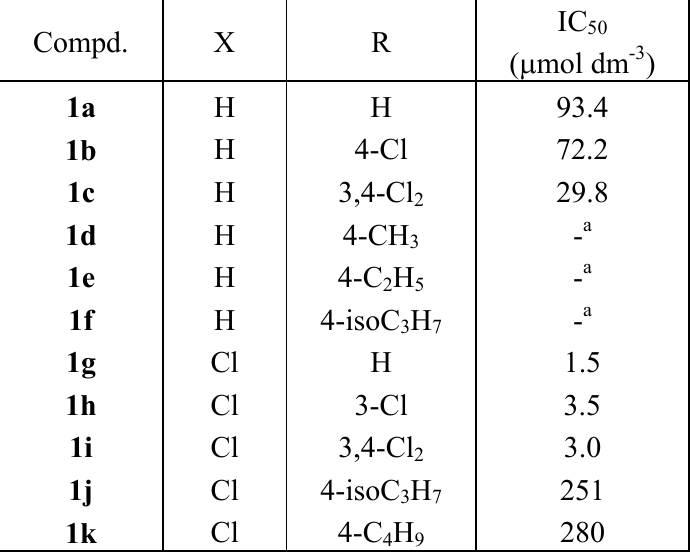
Table 4. Inhibition of oxygen evolution rate in spinach chloroplasts by